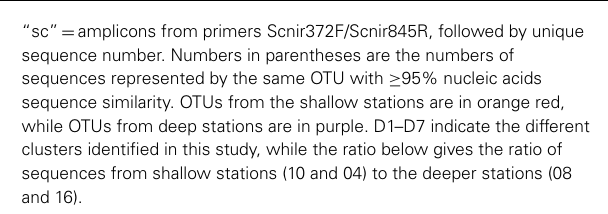
FIGURE 6 | Phylogenetic reconstruction of the denitrifier NirS based on amino acids sequences translated from gene sequences. Sequences were retrieved from clone libraries constructed for sediments of all stations based on maximum likelihood and maximum parsimony algorithms. Bootstrapped values of > 50% are shown for maximum likelihood/maximum parsimony. Indicated in black are the related reference sequences obtained from GenBank. Labeling of sequences: station = 04, 08, 10, or 16, “nir” = amplicons from primers cd3aF/R3cd, or